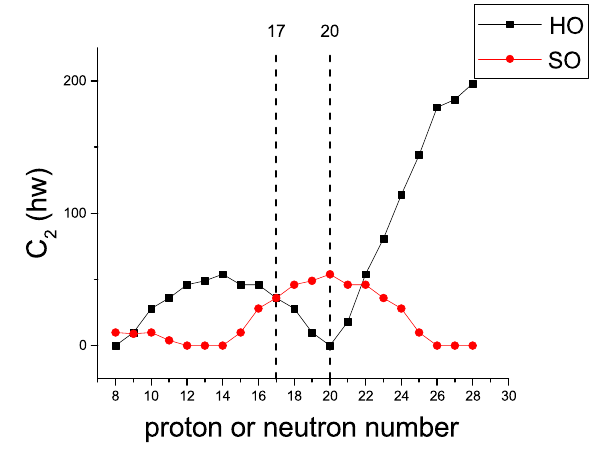
Figure 2. The same as Fig. 1. An island of shape coexistence is predicted within proton or neutron numbers 17 −